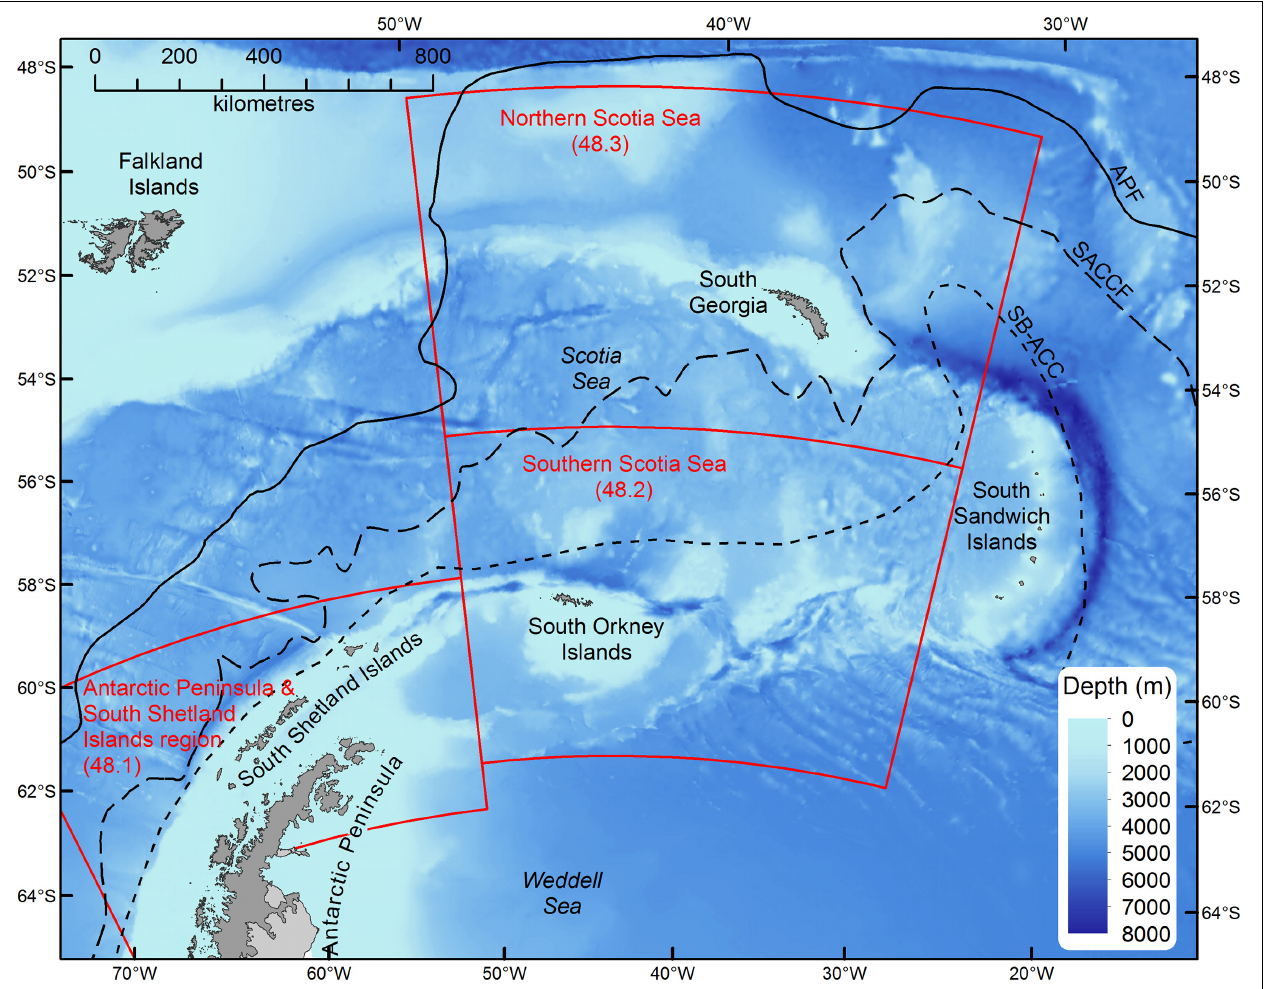
FIGURE 1 | Map of the Scotia Sea – Antarctic Peninsula region. Boundary definitions (red boxes) correspond to the statistical subareas used for catch reporting and fishery management (Hill et al., 2016). Solid and dashed lines show the mean locations of the principle fronts: Antarctic Polar Front (APF), Southern Antarctic Circumpolar Current Front (SACCF), and Southern Boundary of the Antarctic Circumpolar Current